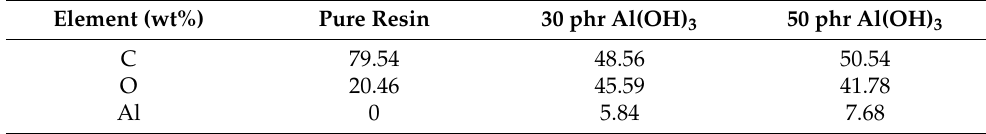
Figure 17. Results from the EDX analysis: ( a ) neat resin, ( b ) resin with 30 phr ATH, ( c ) resin with 50 phr ATH. Table 3. Content of carbon, oxygen, and aluminum elements in the sample volume.